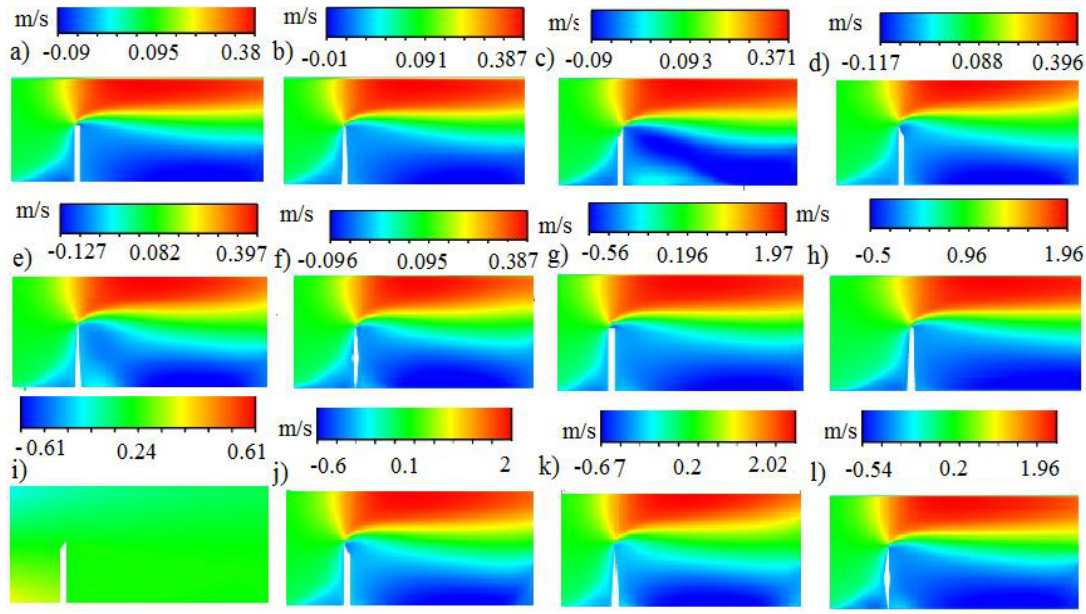
Figure 7. Profiles of axial velocity for different baffles at Re = 20, 000 [a-f] and at Re = 1, 00, 000 [g-l].